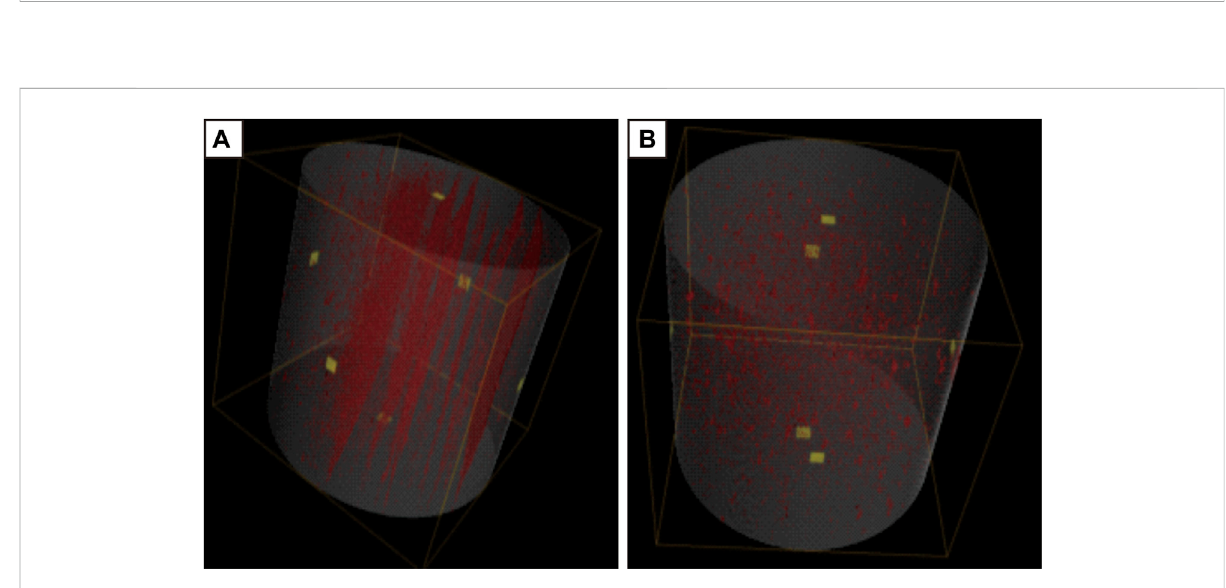
FIGURE 10 Micro-CT showing the 3D pore and connectivity in the marl reservoir: (A) , laminated marl, ST3, 3,670.89 m; (B) , massive marl, ST3, 3,817.65